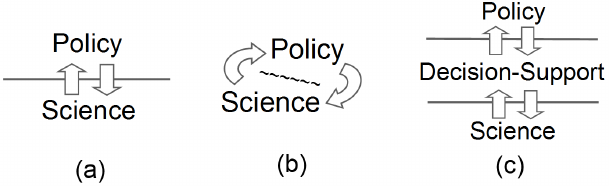
Fig. 5 . Three ways of characterizing the current state